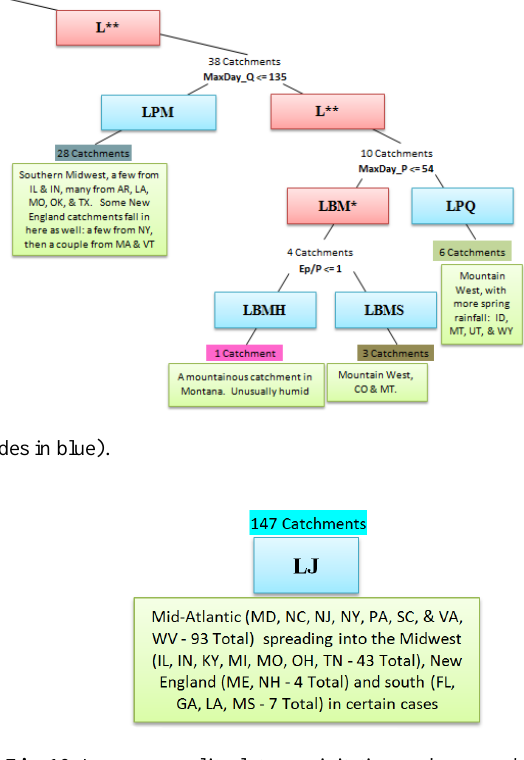
Fig. 10. Low seasonality, late precipitation peak: expanded (termi- nal